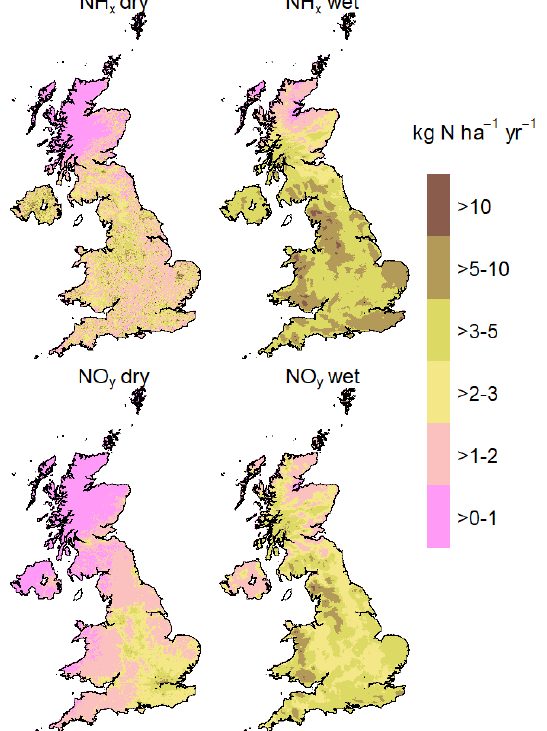
Figure 7. Four forms of nitrogen (N) deposition over the UK ter- restrial surface in 2017 at 1km × 1km resolution, for grid average land cover: wet and dry deposition of reduced N (NH x ) and wet and